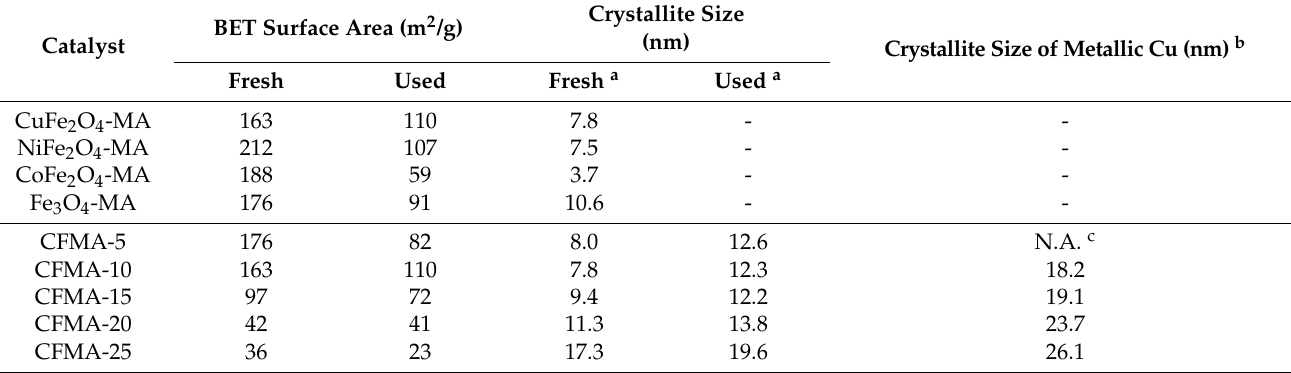
Figure 3. CO conversion of Fe-based catalysts. Table 4. Characteristics of Fe 3 O 4 -MA and MFe 2 O 4 -MA (M=Cu, Ni, Co) and Cu x Fe (3-x) O 4 -MA (x = 0.5, 1.0, 1.5, 2.0, 2.5)